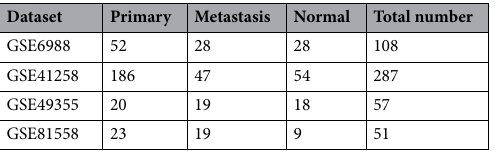
Table 1. Gene expression data extracted from the four GEO